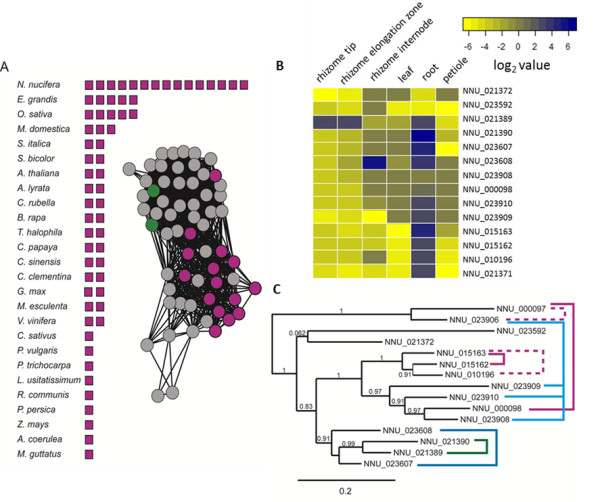
Lotus-specific expansion in LPR1/LPR2 proteins. (A) The number of LPR1/LPR2 homologs in land plants. Homologs detected by Basic Local Alignment Search Tool against the genomes of land plants are represented by a box. A protein similarity network of those proteins is also shown; lotus proteins are represented as purple nodes, Arabidopsis proteins (LPR1 and LPR2) are represented as green nodes and other land plant proteins are represented as grey nodes. (B) Heatmap of COG2132 gene family member expression in lotus. Reads per kilo base per million (RPKM) values were log2 transformed, where blue correlates to high expression, and yellow to low expression. (C) A maximum-likelihood tree of LPR1/LPR2-like lotus proteins. Branch support was calculated using an Approximate Likelihood-Ratio Test. Lotus homologs are connected with a dashed bracket, whereas proteins whose genes are found in tandem on the genome are connected with a solid bracket. A detailed phylogeny of COG2132 members can be found in Figure S8 in Additional file 1.